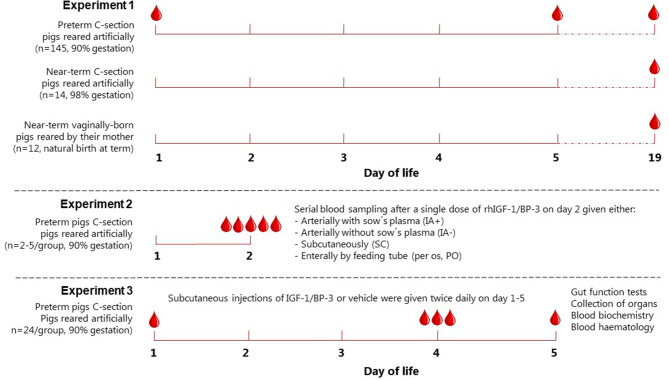
Experimental setup. Schematic drawing showing the experimental setup used to evaluate basal IGF-1 levels in piglets (Experiment 1), pharmacokinetics of IGF-1(Experiment 2) and the effects of rhIGF-1/BP-3 supplementation (Experiment 3). IA+ and IA-, intra-arterial administration with (+) or without (–) maternal plasma immunization; SC, subcutaneous; PO, peroral.